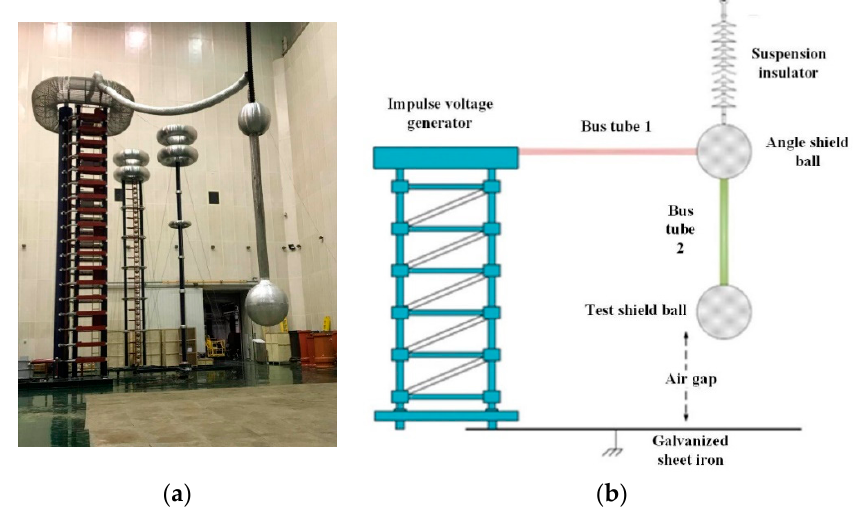
Figure 2. Layout diagram of impulse discharge test on shield ball: ( a ) the test hall of the UHVDC Testing Site; ( b ) experimental schematic diagram.